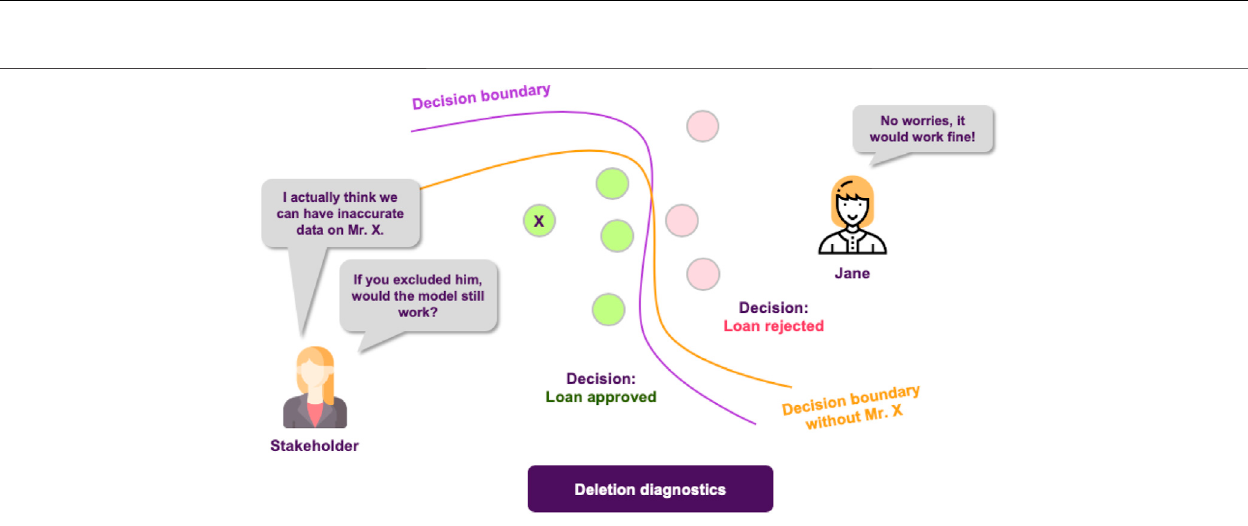
Figure 14 discuss a sample pipeline in terms of approaching explainability for machine learning, and Figure 15 7 and Figure 16 8 discusses possible methods.